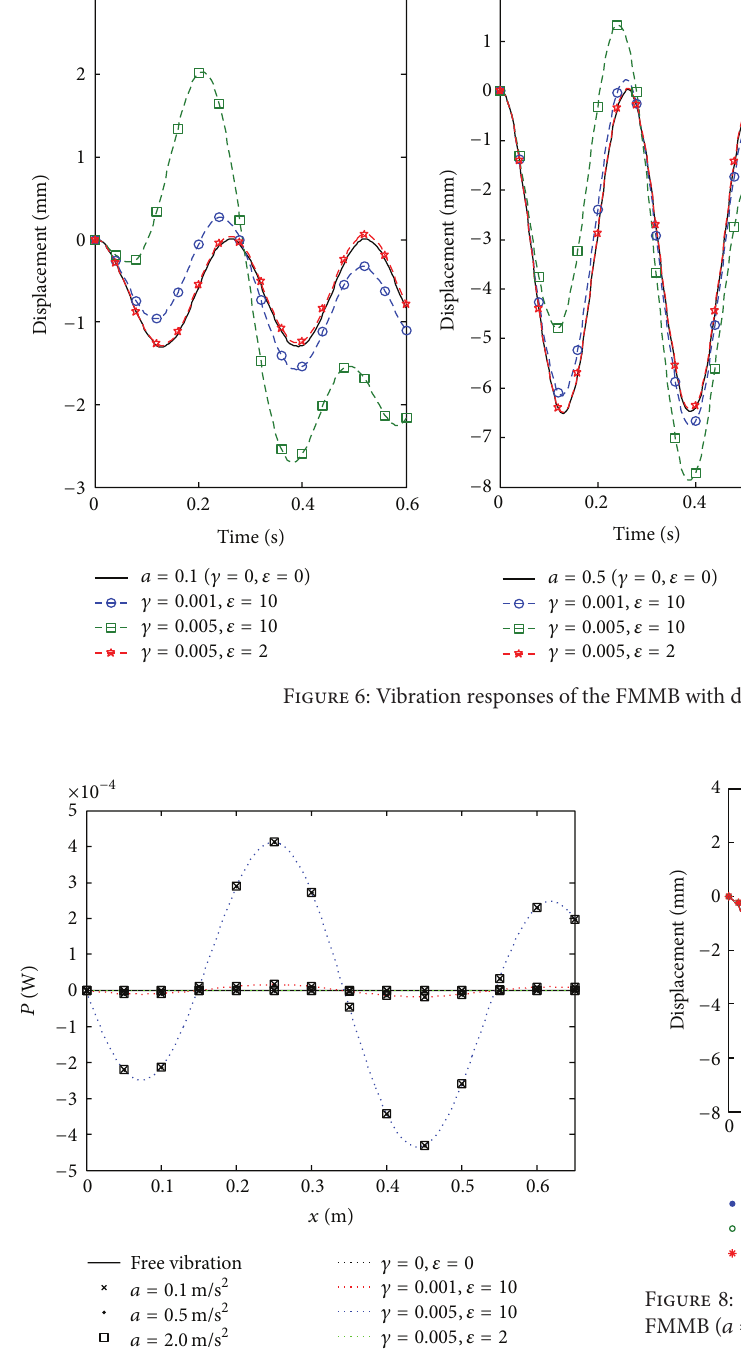
Figure 7: Power flow of the FMMB with disturbance accelerations.